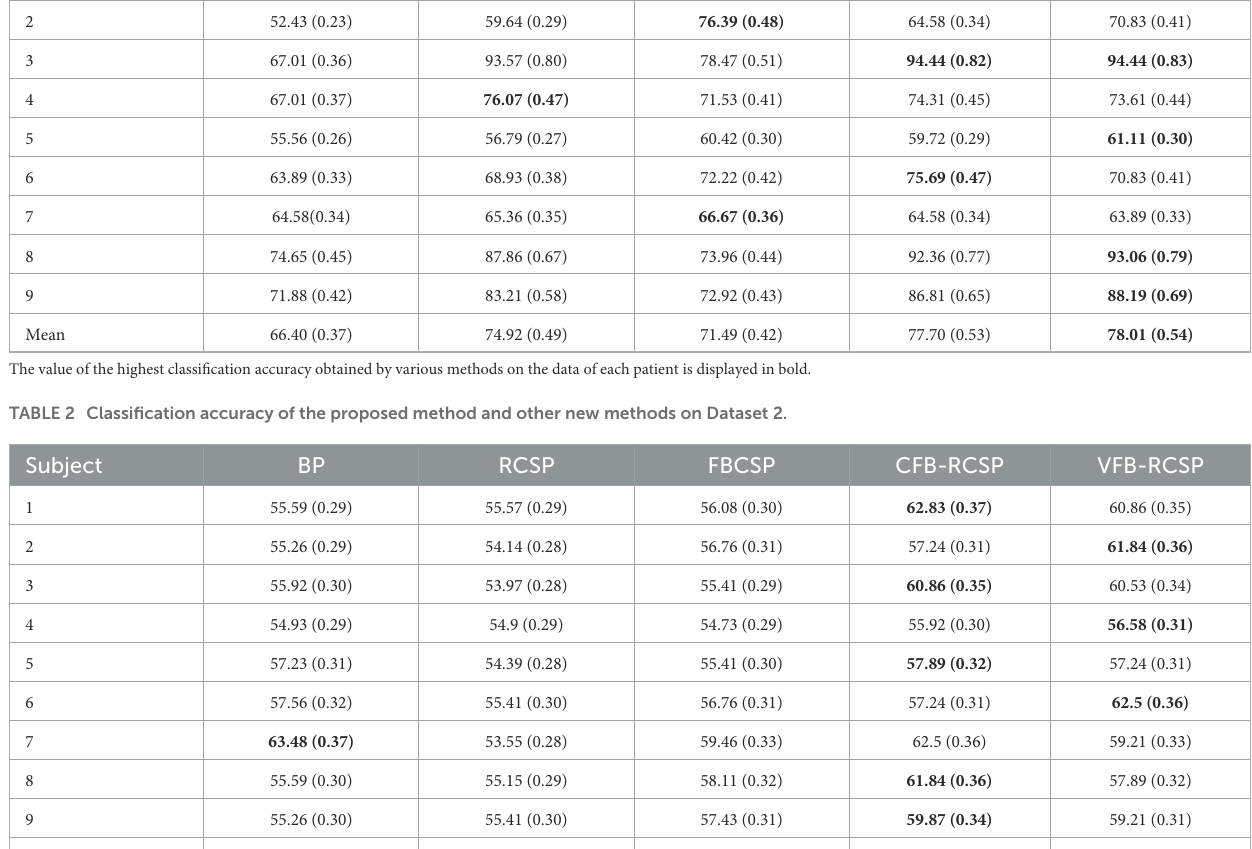
Figure 5 visualizes the two datasets’ average classification accuracy and standard deviation under different methods. In Dataset 1, the average classification accuracy and standard deviation for each method are: BP (66.40 ± 8.81), RCSP (74.92 ± 12.93), FBCSP (71.49 ± 5.33), CFB − RCSP (77.70 ± 12.96), VFB